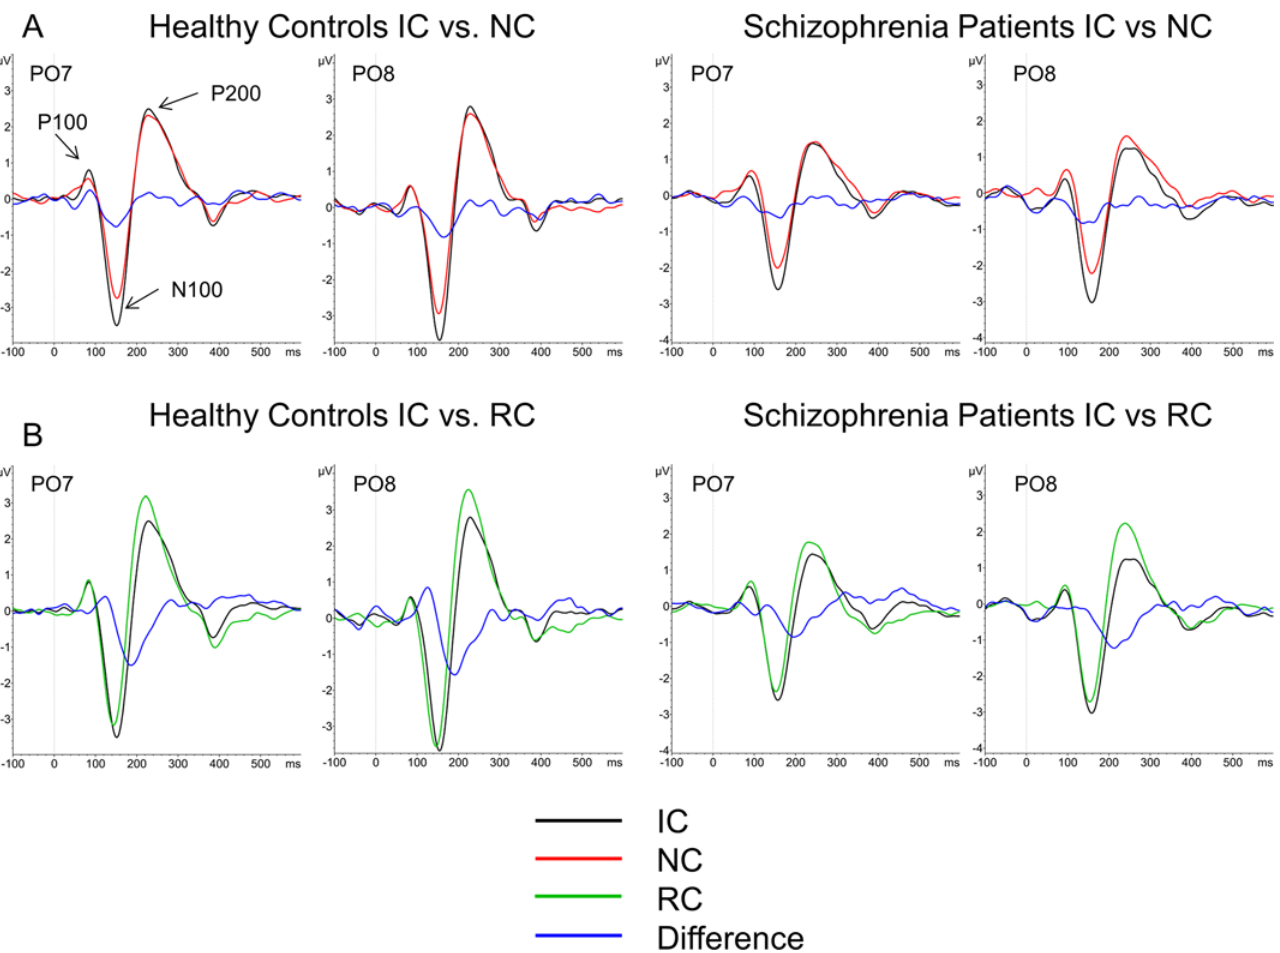
Fig 3. ERPs at electrodes PO7 and PO8, with the P100, N100 and P200 marked with arrows. A) ERPs comparing the IC (black) and NC (red) stimuli along with the IC-NC difference (blue). B) ERPs comparing the IC (black) and RC (green) stimuli along with the IC-RC difference